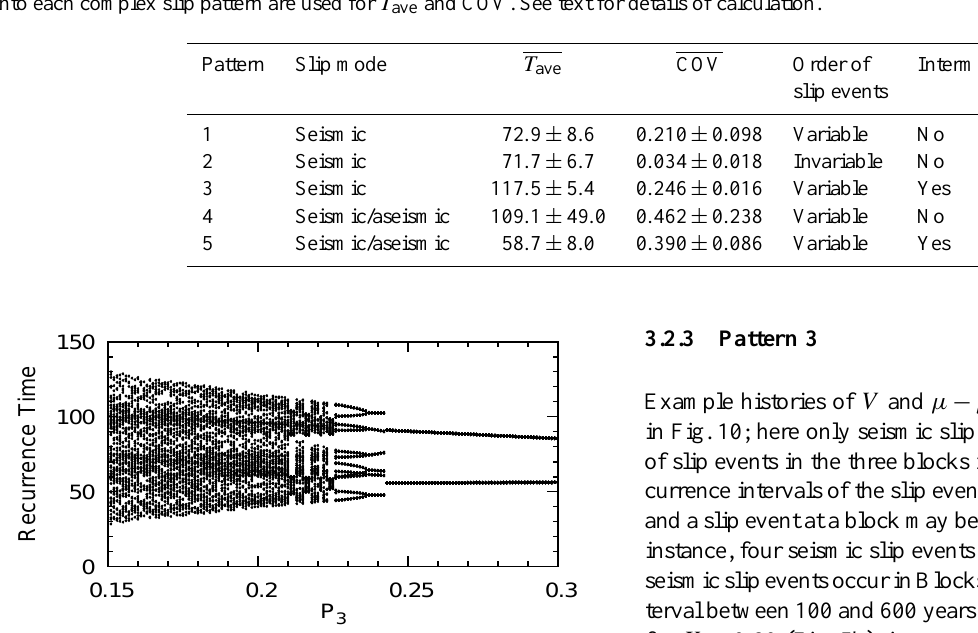
Figure 7. Bifurcation diagram of recurrence intervals of slip events at Block 1 near the transition boundary between multiperiodic pat- terns and complex pattern 1. The model parameters are K = 1 . 00, P 1 = 0 . 450, and P 2 = 0 . 100, and P 3 ranges from 0.15 to